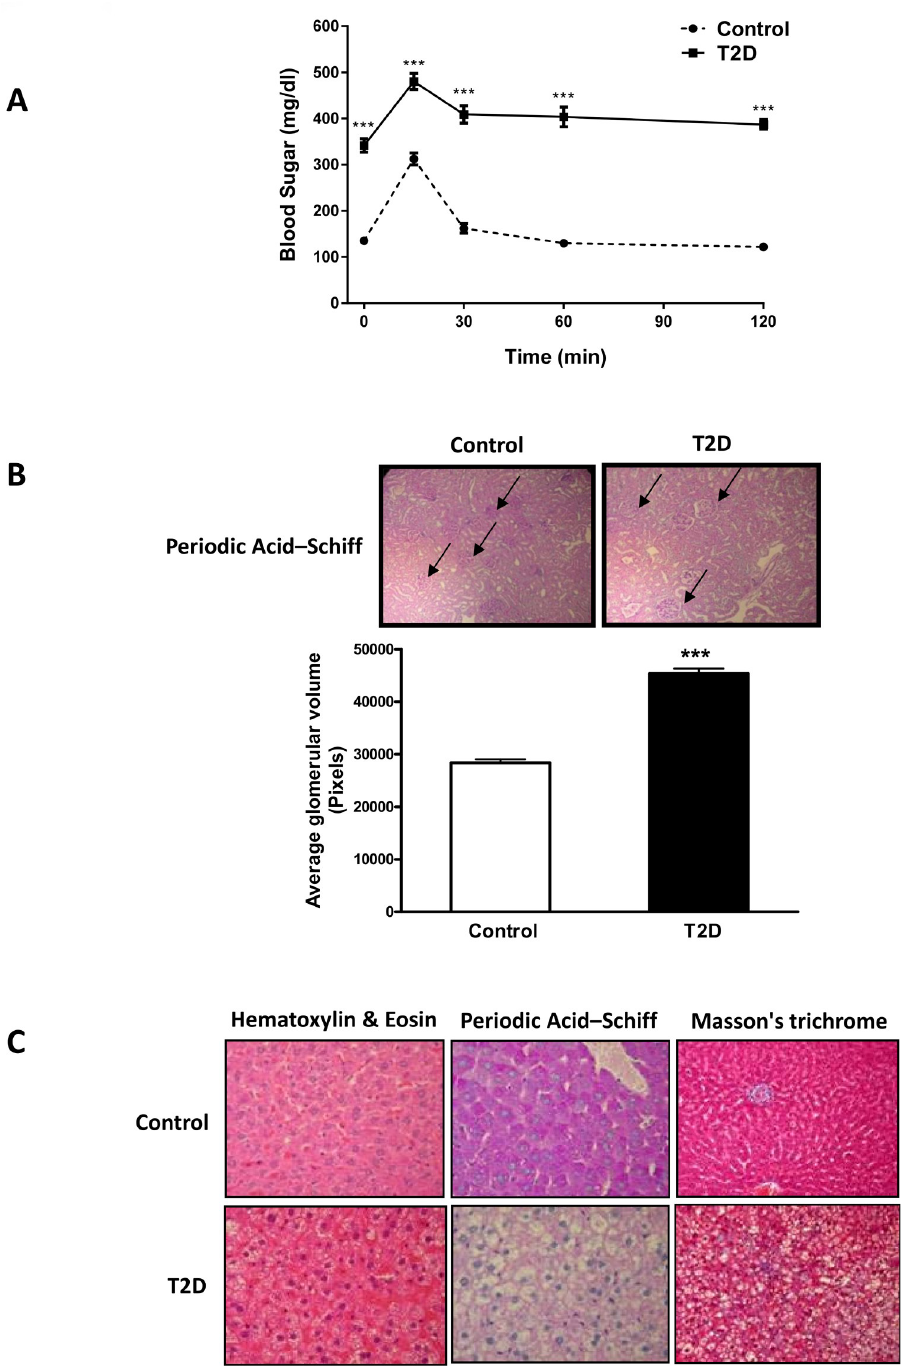
Fig 1. Pathological characteristics of HFSTZ-induced T2D rats. (A) Evaluation of the extent of glucose intolerance in the T2D rats induced by HFSTZ. Data are the mean ± standard error of the mean (SEM; n = 8). ��� = p < 0.001 versus control group. (B) Evaluation of the glomerulus volume between the control rats and T2D rats. Representative images of the glomerulus stained with Periodic Acid–Schiff (PAS) are illustrated. Glomerular volume was quantified by the pixels of a randomly selected glomerulus. Data are the mean ± SEM (n = 300 from three rats). ��� = p < 0.001 versus control group. (C) Evaluation of the extent of hepatic steatosis in the T2D rats. Liver sections of control or T2D rats were stained with hematoxylin & eosin, PAS, or Masson’s trichrome. Representative images are illustrated